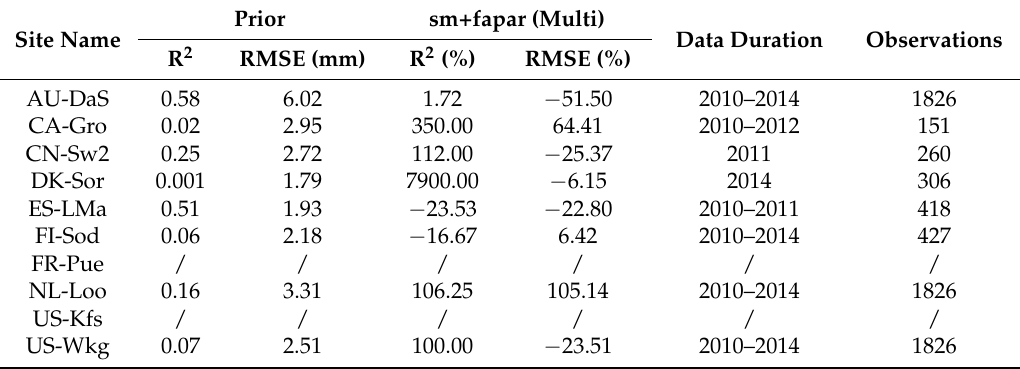
Table 4. R 2 and RMSE relative changes (%) to prior simulation for site soil moisture calculated against in-situ observations when SMOS soil moisture and FAPAR were assimilated simultaneously in multi-site case, denoted as sm+fapar